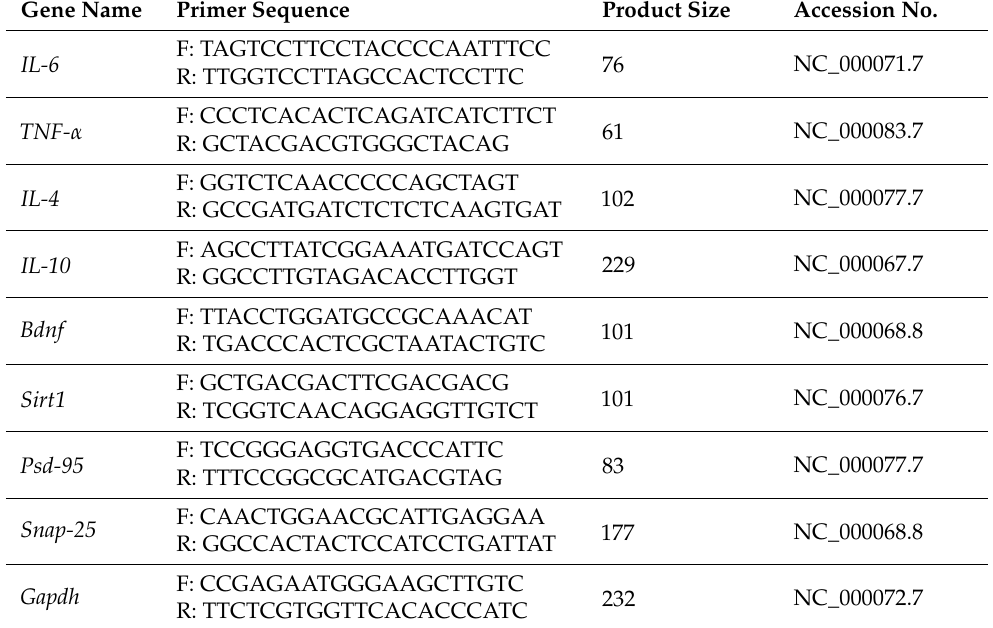
Table 1. Primers for real-time